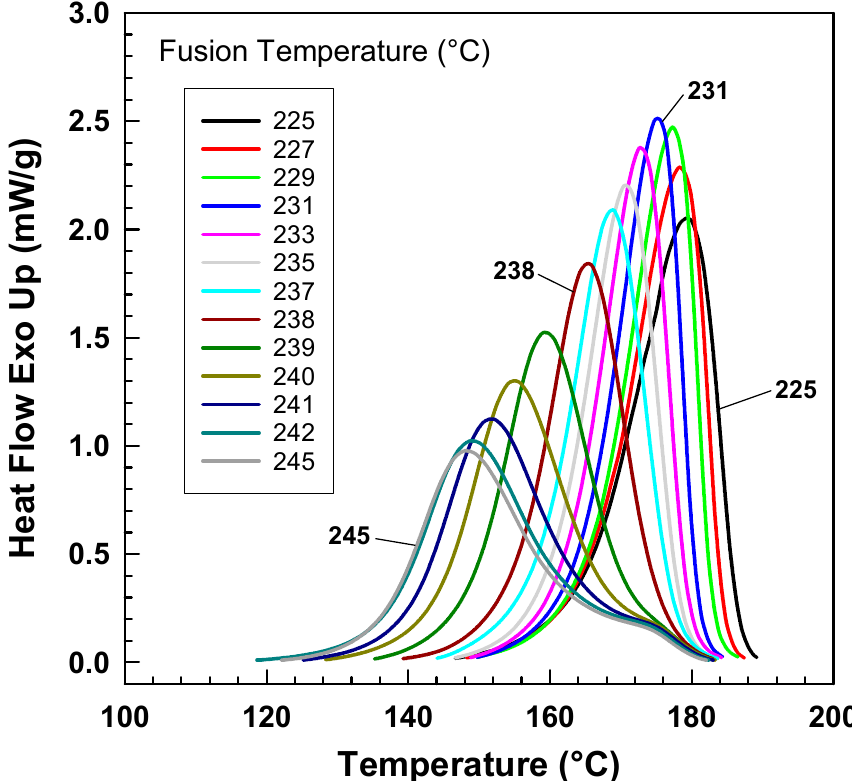
Figure 2. Exothermic heat flow of PA6 from DSC after various fusion temperatures at a cooling rate of 25 °C/min.